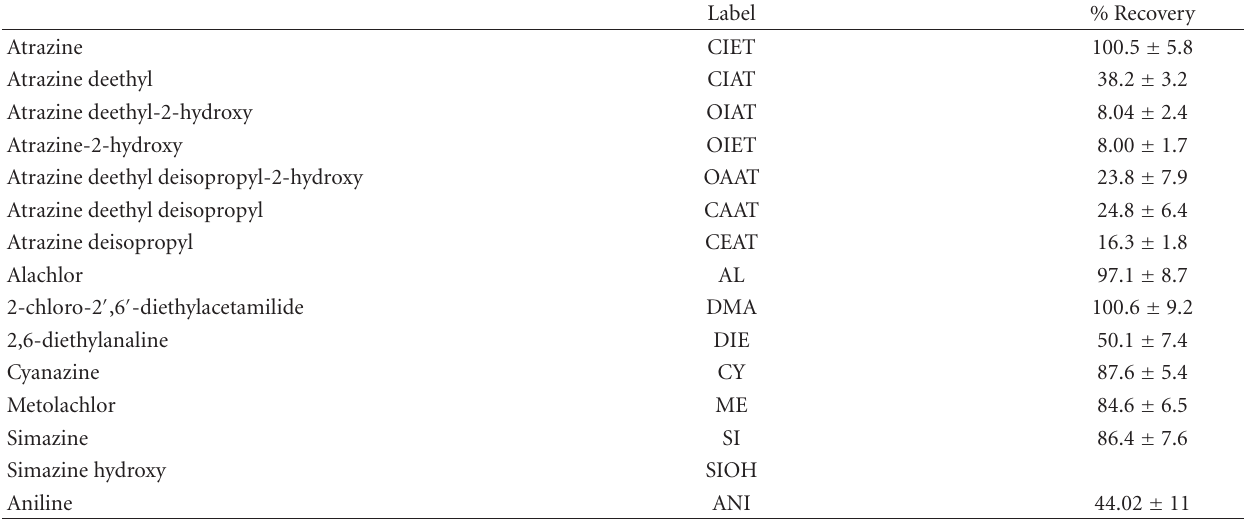
Table 1: A list of the compounds monitored by HPLC and % recovery at the 95% level of confidence. All compounds were purchased from ChemService, Inc. (West Chester, Pa) and used as received.